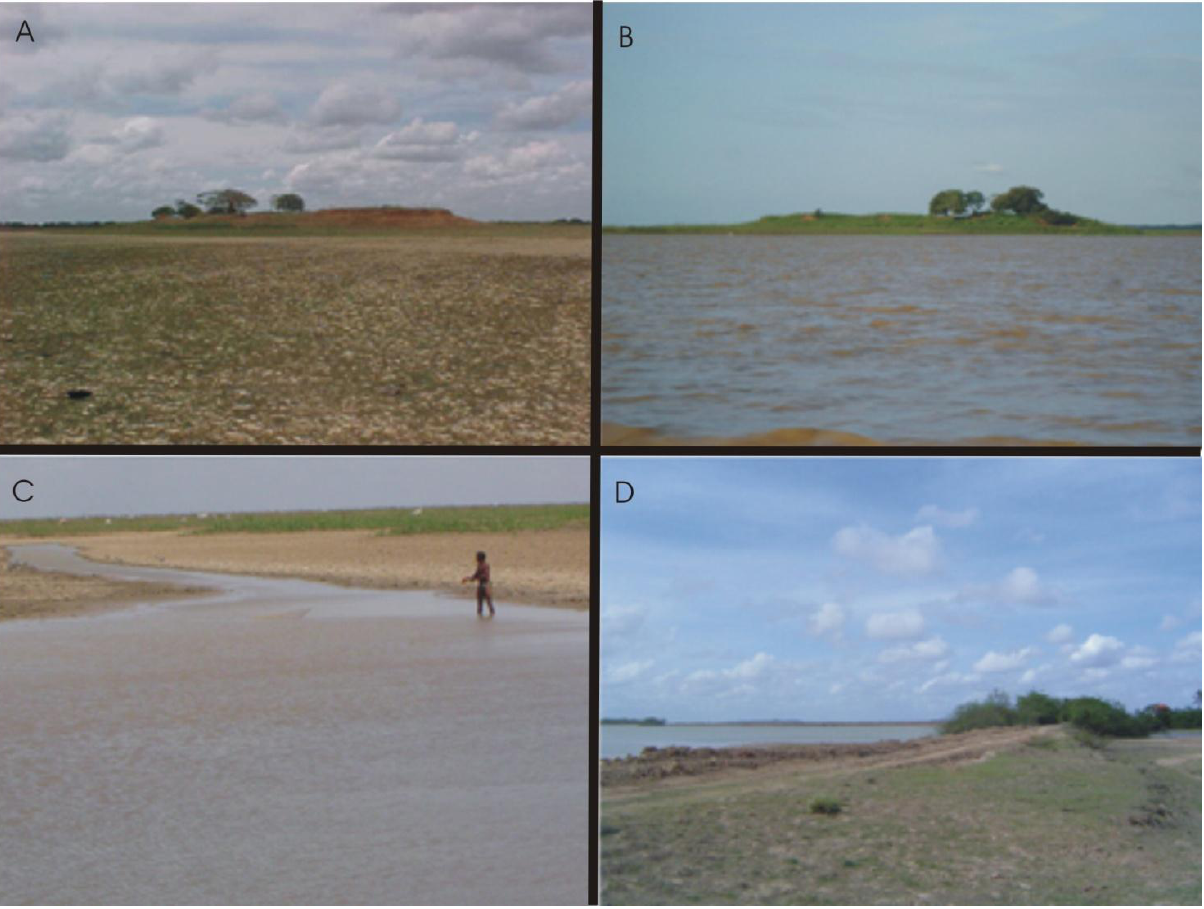
Figure 4. Landscape change due to climate and human action: (a) Teso dos Bichos archaeological mound in January and (b) in May. (c) Fishing in temporary